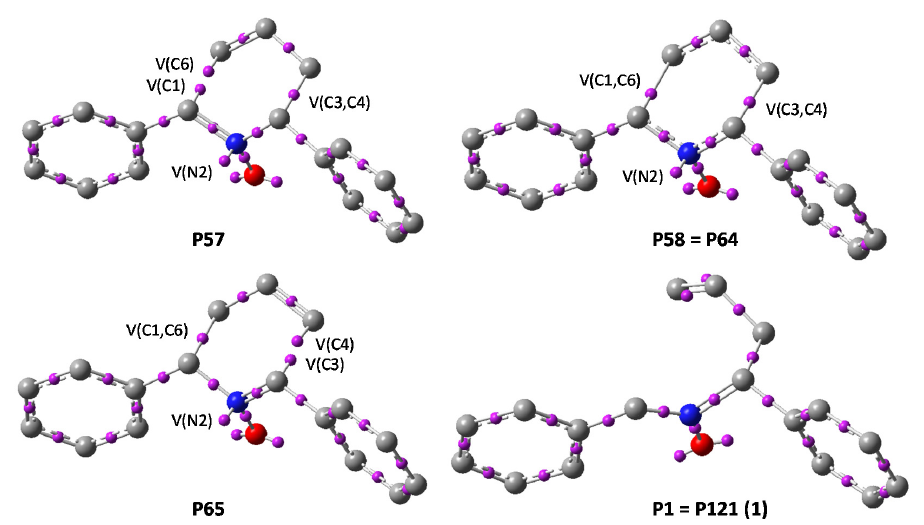
Figure 4. ELF attractor positions for the most relevant points of the IRC associated with the 2-aza- 2-aza-Cope rearrangement of nitrone 1 . Representation of TS ( P61 ) is essentially the same that P58=P64 ,